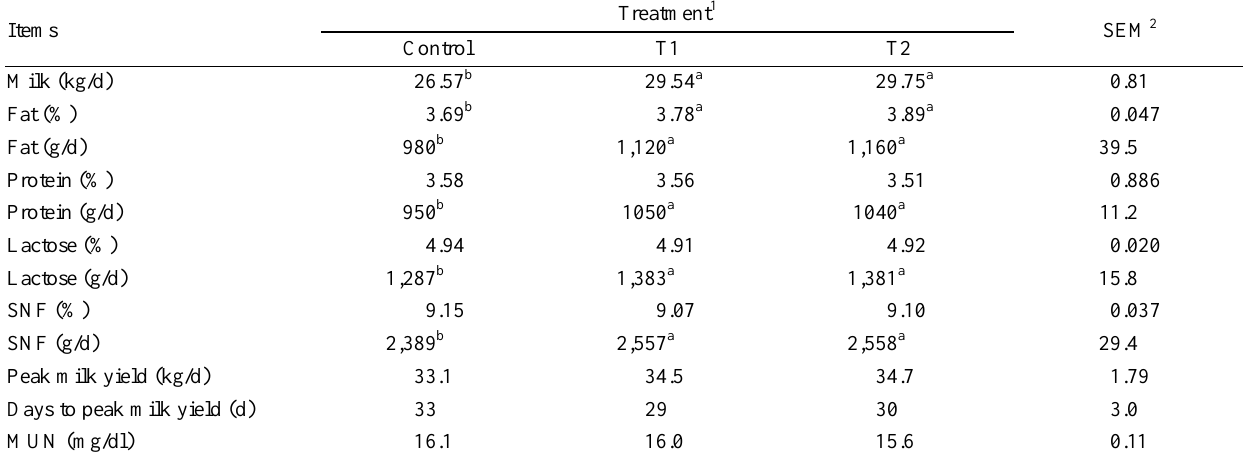
Table 2. Effects of HMBi supplementation on DMI as well as on milk production and composition Items